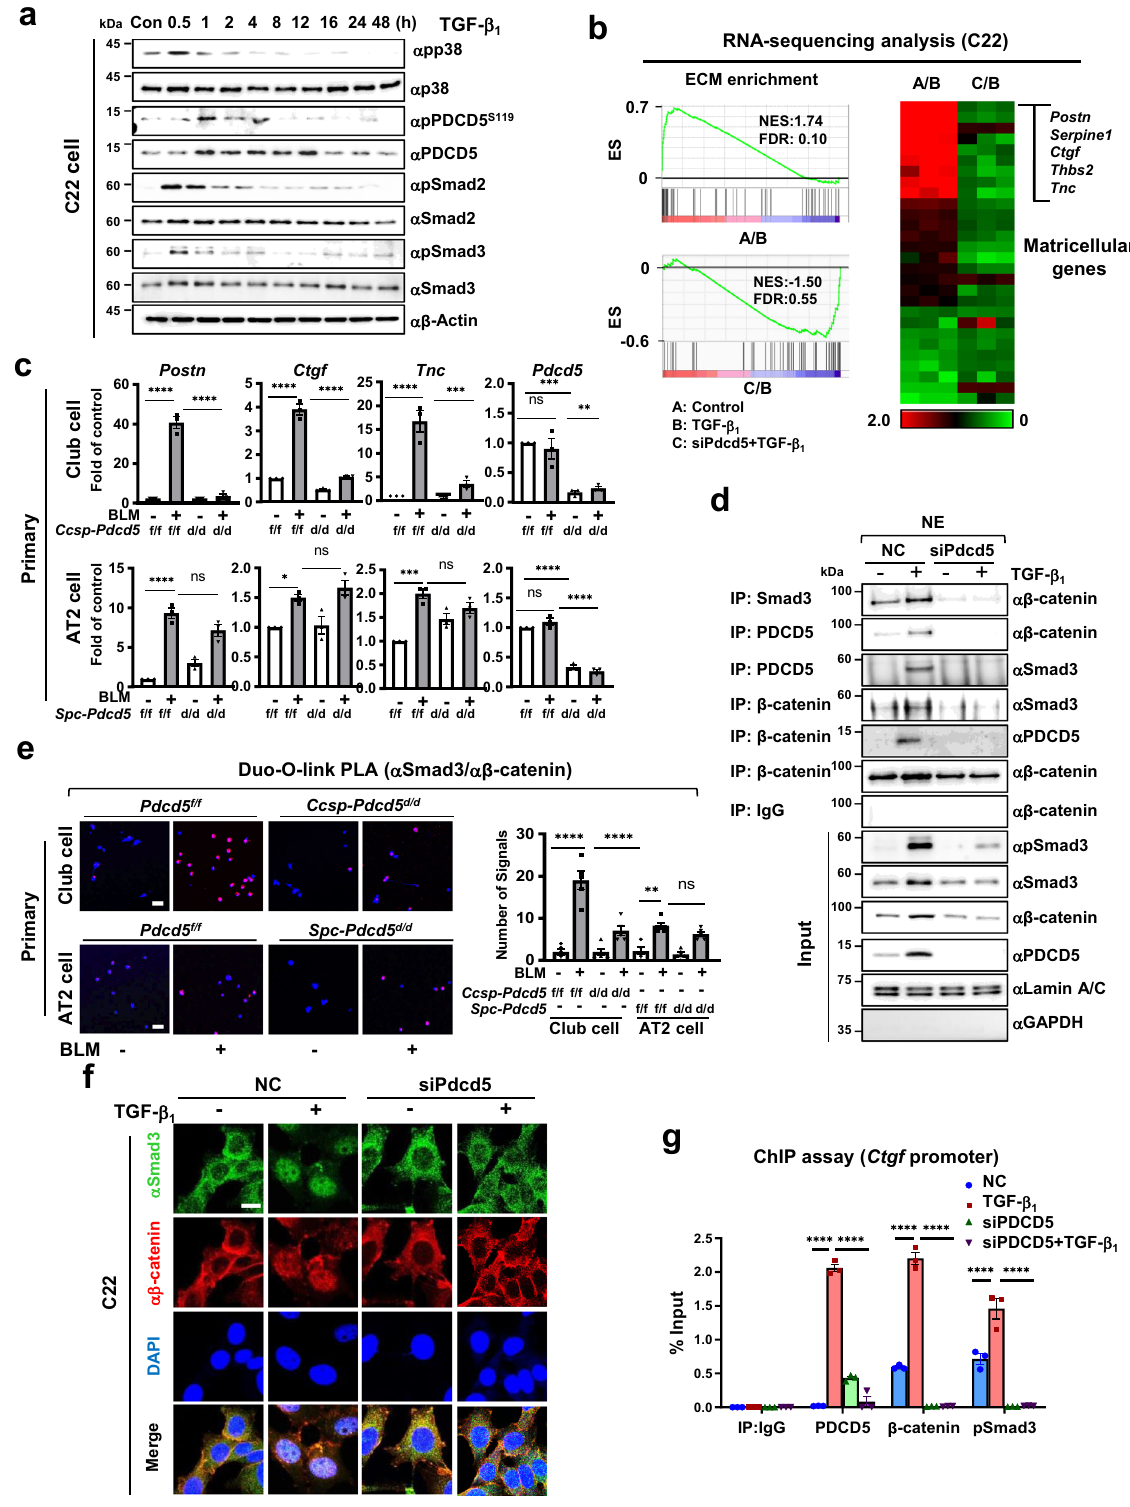
p38 MAPK phosphorylates PDCD5 Ser-119, leading to phosphorylation of PDCD5 at Ser-119 is required for PDCD5 stabilization and nuclear translocation in a response PDCD5 stabilization and nuclear translocation in response to to TGF- β . Casein kinase 2 (CK2) phosphorylates PDCD5 at Ser- TGF- β 1 . First, we tested whether PDCD5 phosphorylation at Ser- 119 upon genotoxic stress, which enhances its stability and pro- 119 is required for TGF- β -induced nuclear translocation of motes translocation into the nucleus 9,21 . Since PDCD5 expression PDCD5. Wild-type PDCD5 (PDCD5 WT ) was rapidly translo- was increased in the lungs of patients with IPF and in the lungs of cated into the nucleus upon TGF- β 1 treatment. However, a phospho-defective mutant (PDCD5 S119A ) did not translocate to mice with fi brosis, we examined whether CK2-mediated NATURE COMMUNICATIONS| (2021) 12:2923